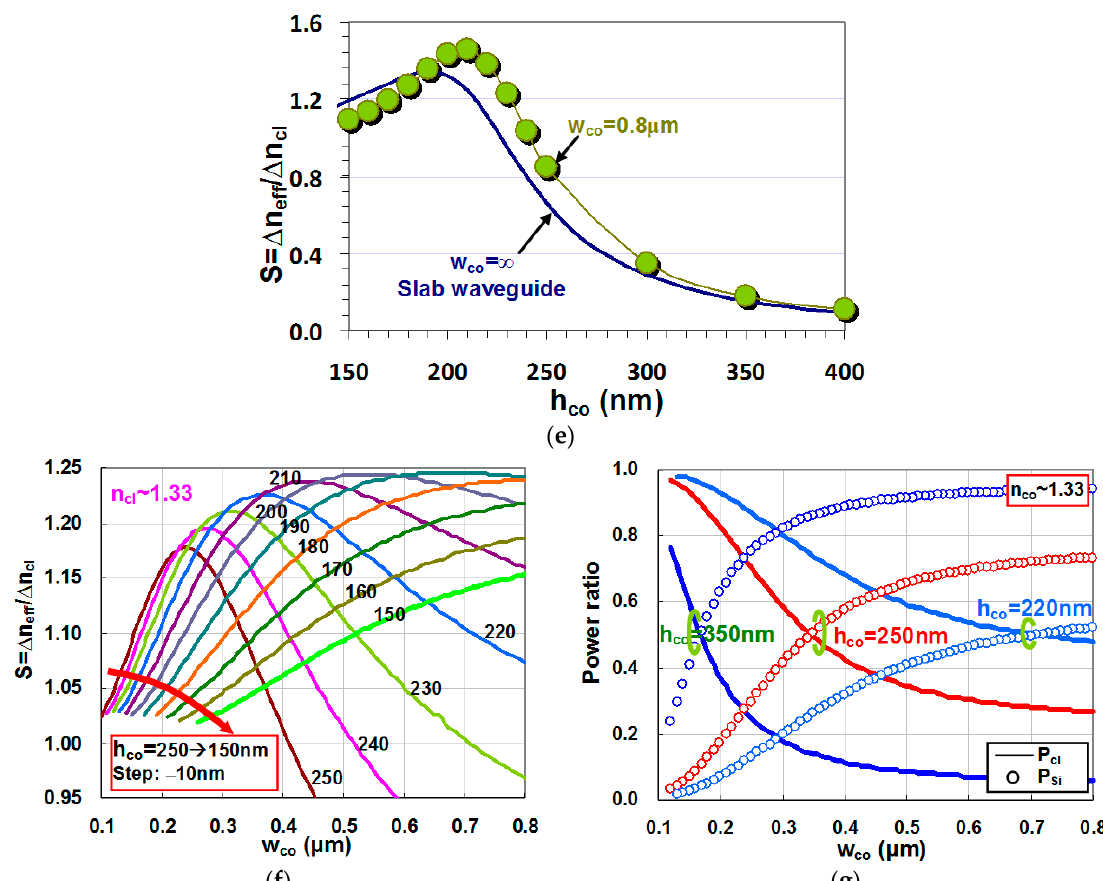
Figure 3. ( a ) The cross section of a suspended Si nanowire; ( b ) the calculated field distribution of the TM fundamental mode for a suspended Si nanowire waveguide with h co = 220 nm, w co = 525 nm, and n cl = 1.0; ( c ) the sensitivity of a suspended Si nanowire for gas sensing (ncl ~ 1.0); ( d ) the power confinement ratio in a suspended Si nanowire for gas sensing; ( e ) the calculated sensitivities for a suspended Si nanowire with w co = 0.8 μ m and w co = ∞ (slab waveguide); ( f ) the sensitivity of a suspended Si nanowire for liquid sensing (n cl ~ 1.33); and ( g ) the power confinement ratio in a suspended Si nanowire for liquid sensing.